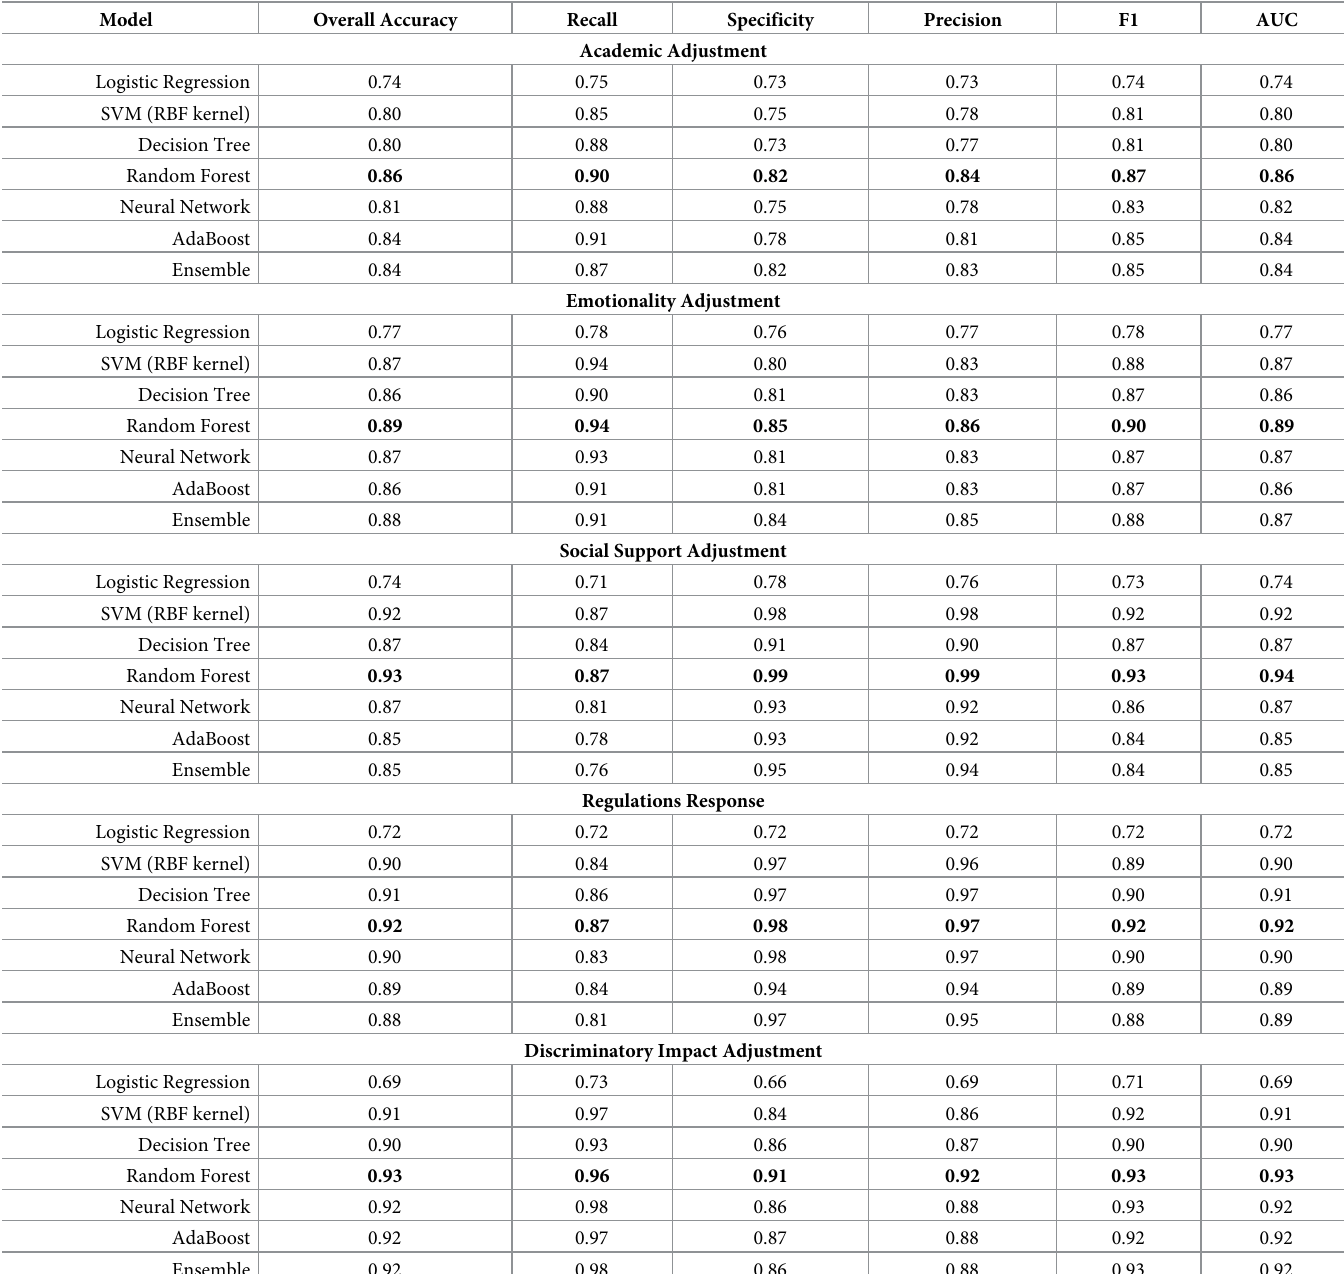
Table 3. Performance of seven machine learning models for each classification